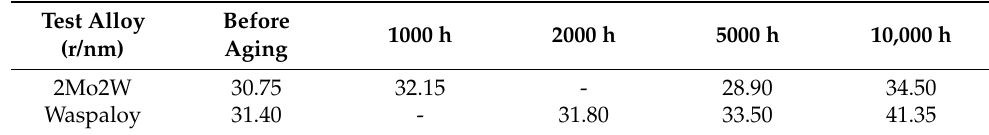
Table 3. γ (cid:48) phase size of test alloys before and after treatment.